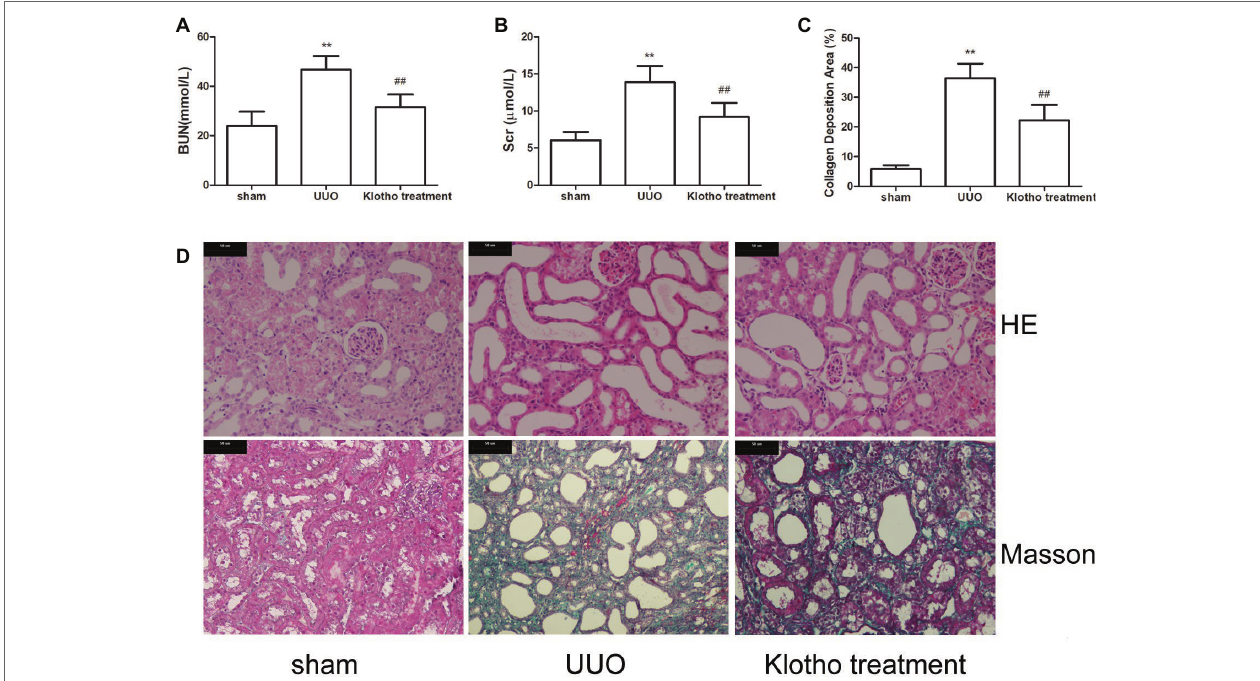
FIGURE 1 | Renal function and tubulointerstitial fibrosis were reduced by Klotho administration in UUO mice. (A) Blood urea nitrogen alteration in experimental groups. (B) Serum creatinine alteration in experimental groups. (C) Quantification of tubulointerstitial fibrosis. (D) Representative images of renal fibrosis were analyzed by HE and Masson’s trichrome staining in experimental groups. ** p ≤ 0.01 versus sham group; ## p ≤ 0.01 versus UUO